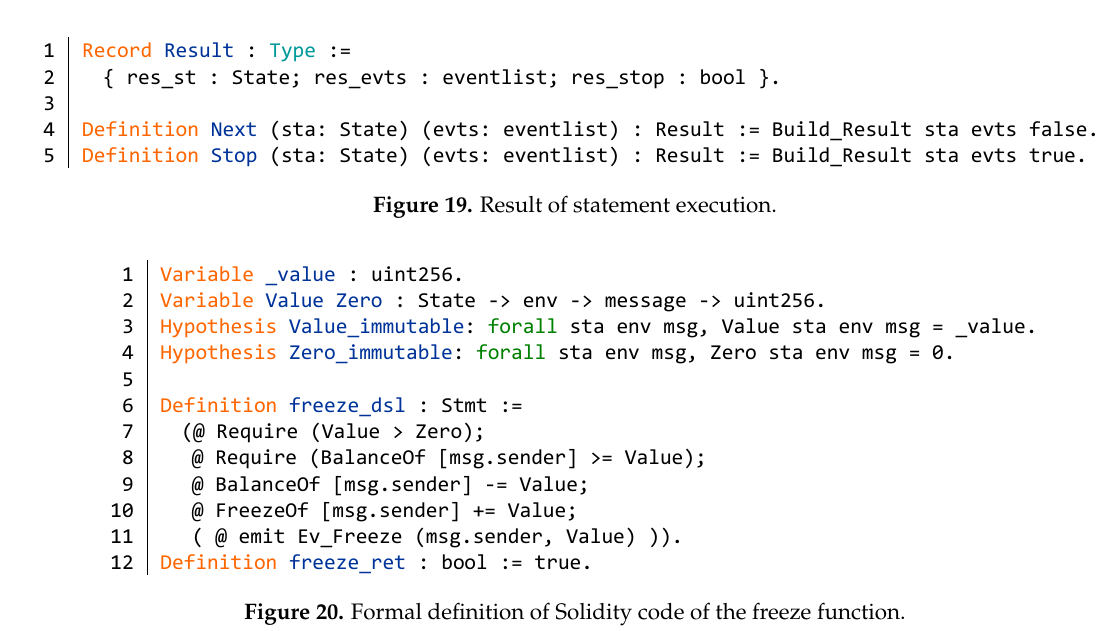
Figure 18. Definition of domain specific language (DSL) statements in the freeze function.